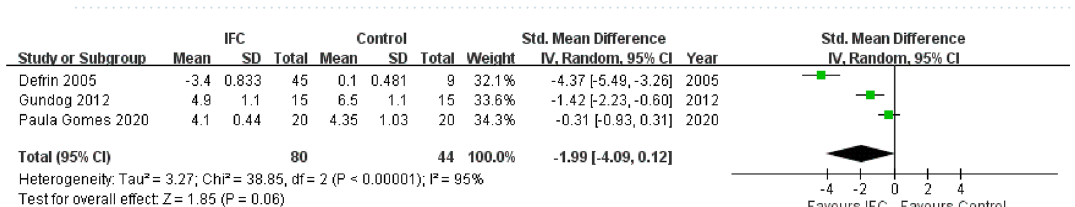
Figure 4. Forest plot of walk test results of IFC and control groups. IFC interferential current therapy, PBM photobiomodulation, 95% CI 95% confidence interval.